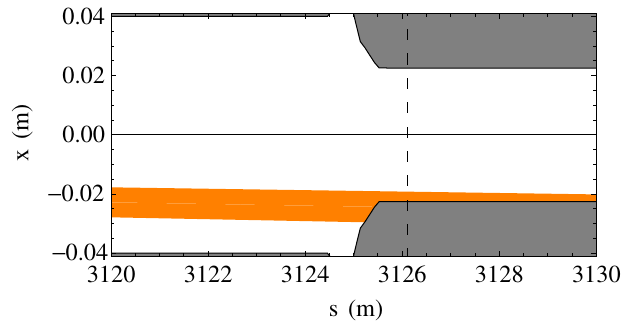
FIG. 16. (Color) The impact of the 6 (cid:1) envelope of the 206 Pb 82 þ ions created by EMD2 at IP2 at an aperture restriction. The projected longitudinal rms spot size on the beam screen is only 2.9 cm. The loss takes place in a drift section and the beginning of next magnet, a corrector, is indicated by a dashed vertical